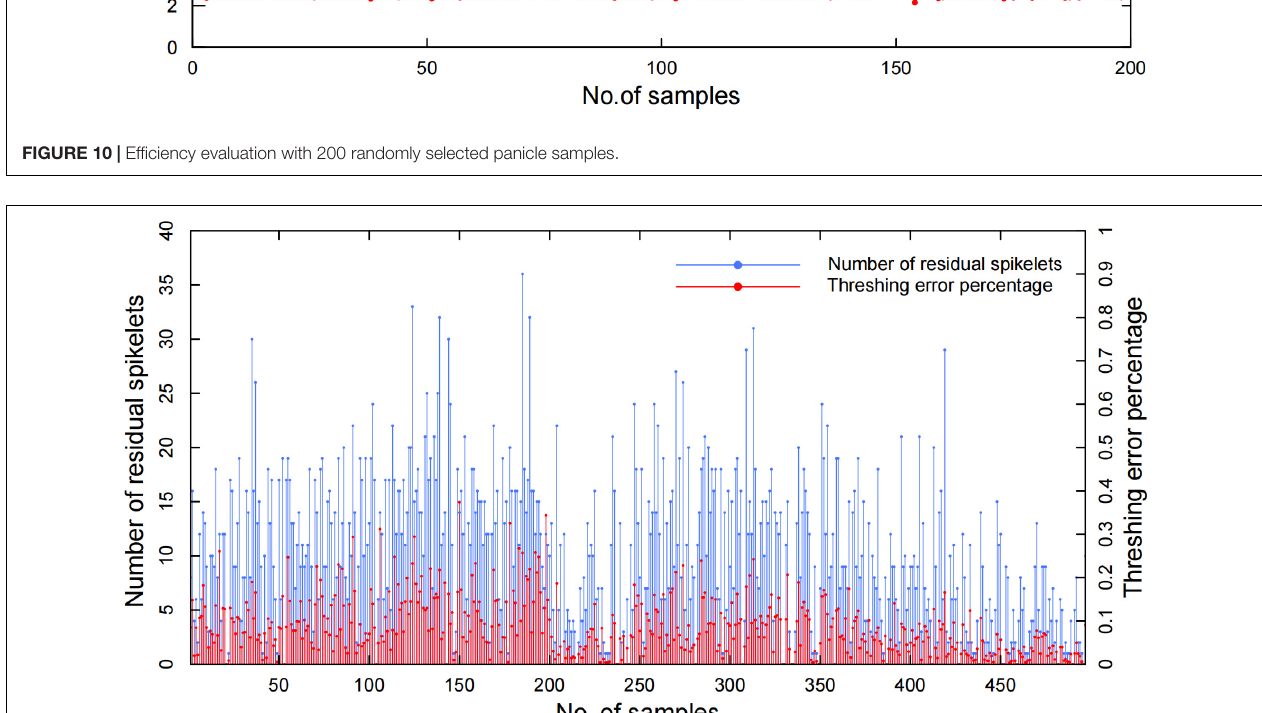
FIGURE 11 | Automatic threshing performance of the residual spikelet number and threshing error